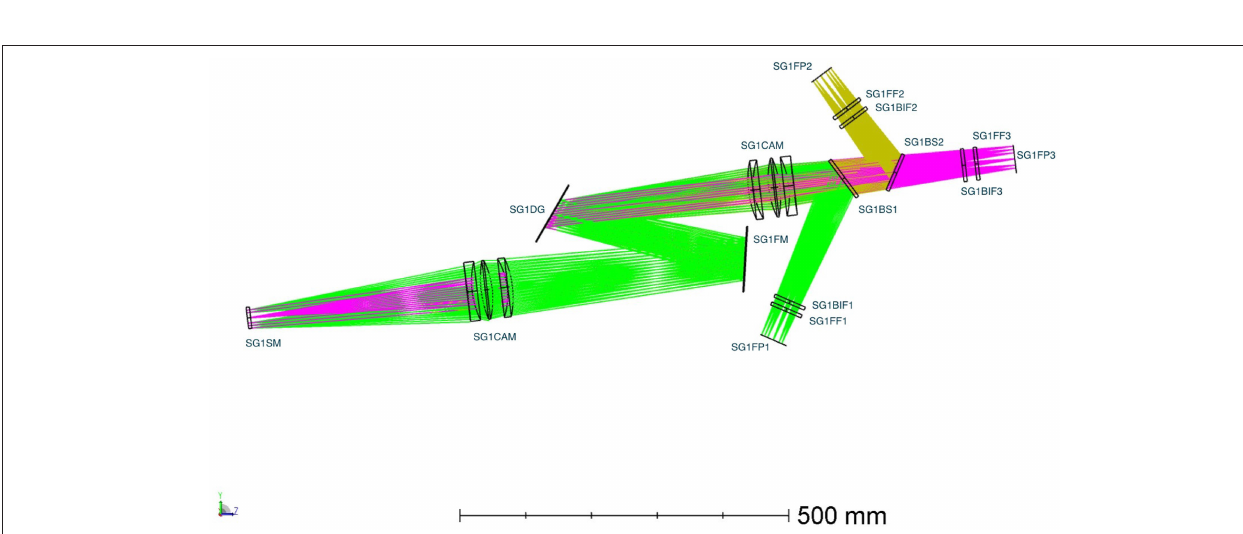
FIGURE 7 | Left: Spot diagram of the catadioptric off-axis Gregorian coronagraph at its Gregorian focus. Right: Encircled energy.